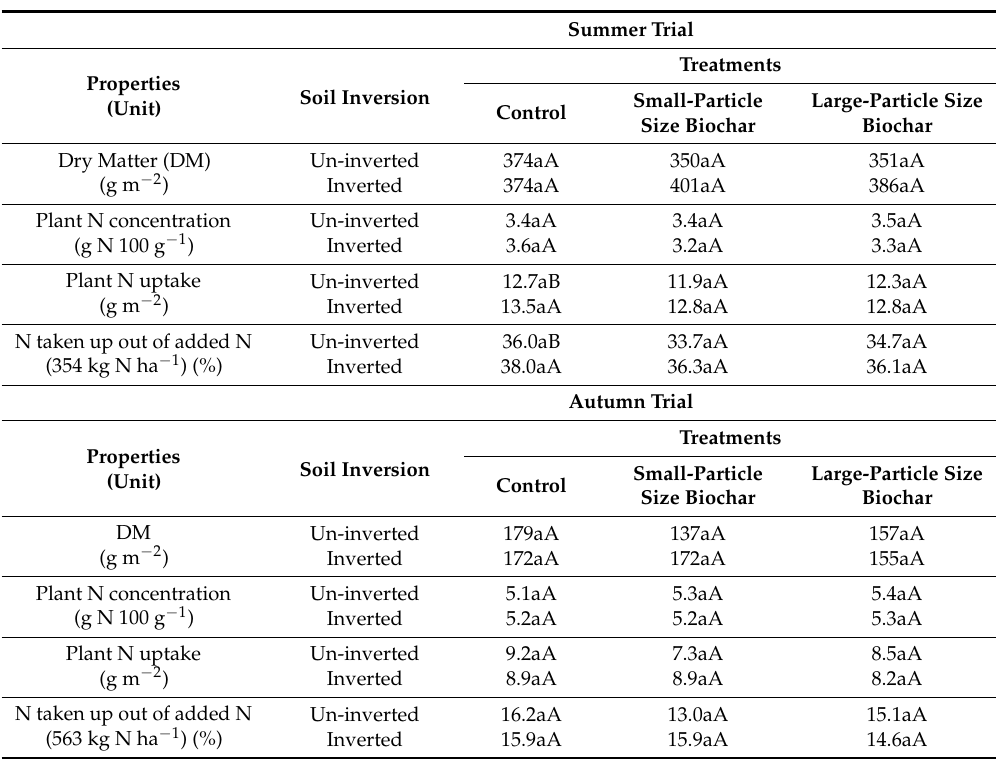
Table 3. Treatment and soil inversion effects on dry matter yields, plant N concentration, plant N uptake, and percentage of the total N applied taken up by plant for summer and autumn